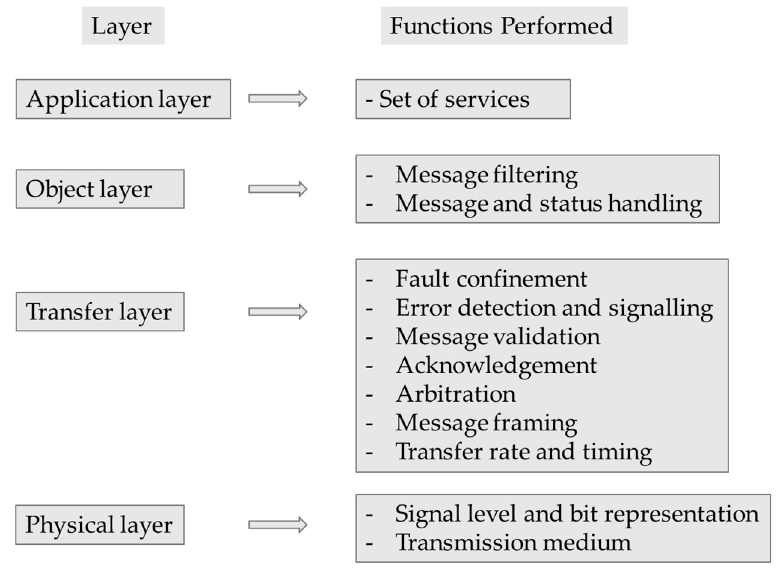
Figure 3. Layered structure of the Controlled Area Network (CAN) bus.